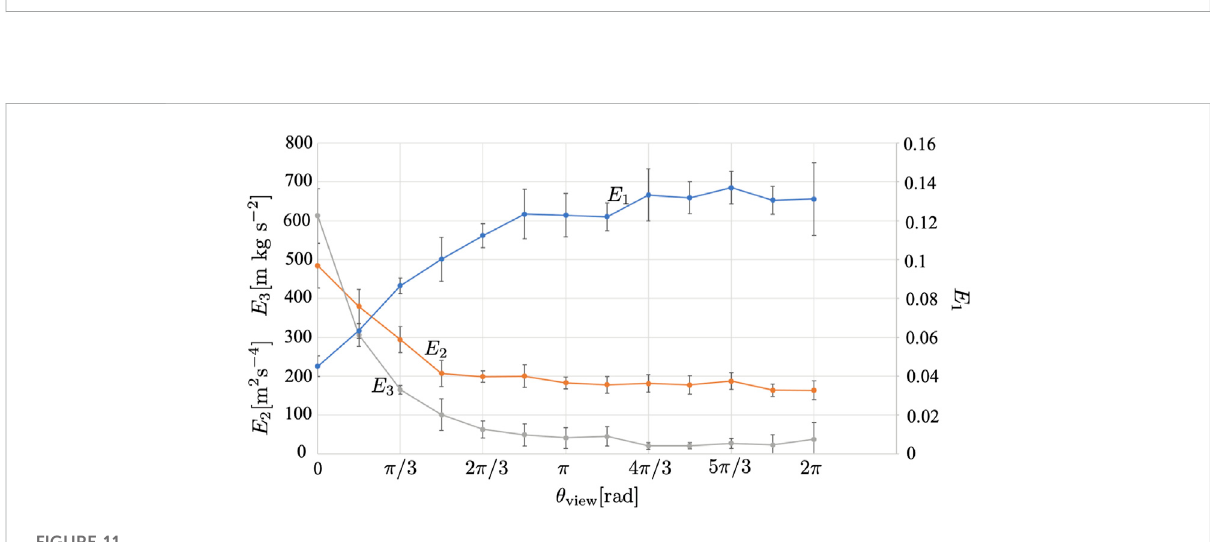
FIGURE 11 Result when the central angle of the observation range θ view is varied. The average over fi ve trials is shown. The error bars denote the standard